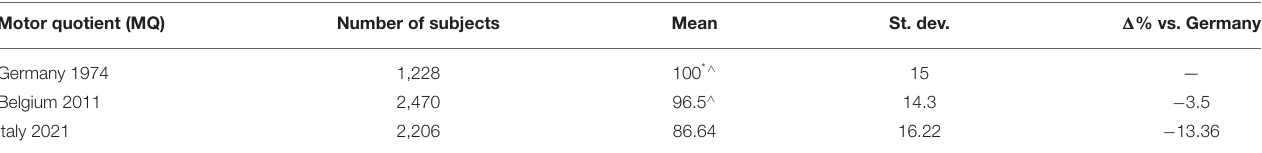
TABLE 5 | The number of subjects, means, standard deviations, and differences (percentages) of the motor quotient (MQ) in three comparable searches: Kiphard (46), Germany; Vandorpe et al. ( 45), Belgium; and our research, Italy, 2021. Motor quotient (MQ) Number of subjects Mean St. dev. 1 % vs. Germany Germany 1974 1,228 100 * ∧ 15 — Belgium 2011 2,470 96.5 ∧ 14.3 − 3.5 Italy 2021 2,206 86.64 16.22 −